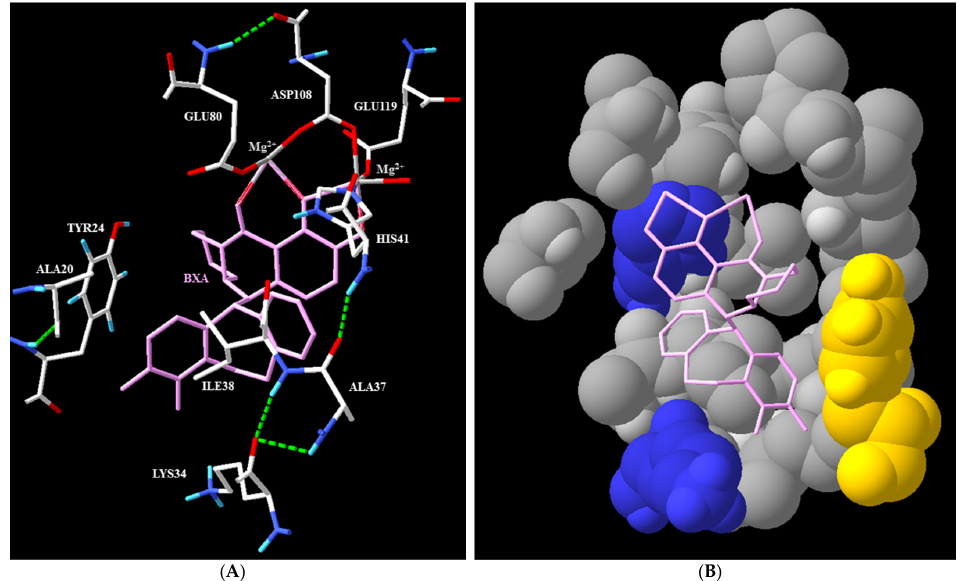
Figure 3. ( A ) Model obtained using SwissPDBViewer ® 4.1.0. from the X-ray diffraction structure analysis of BXA (pink) complexed in Influenza A/California/04/2009 (pH1N1) endonuclease (PDB code: 6FS6) [4]. ( B ) A reverse view of the binding site showing the hydrophobic character of the BXA binding site (color code for amino acids: hydrophobic ones in grey, basic ones in blue, and aromatic ones in yellow).